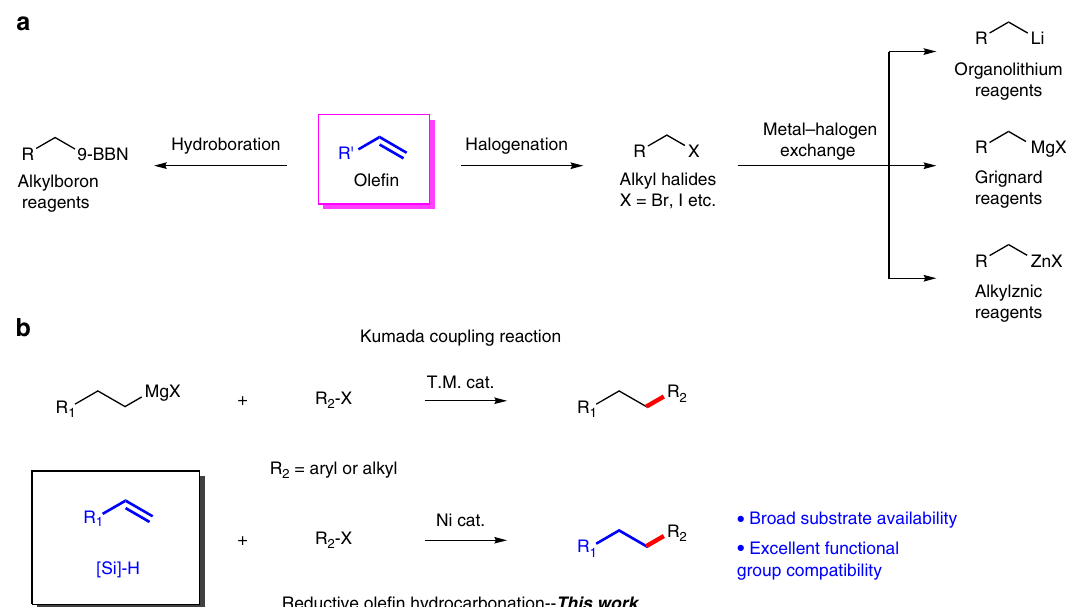
Figure 1 | Carbon–carbon bonds formation from olefins. ( a ) Alkyl organometallic reagents used in cross-coupling reactions. Alkylboron reagents 47–49 are usually made through alkene hydroboration. Grignard 50,51 , organolithium 52,53 and alkylznic reagents 42,54 are generally obtained through insertion of metals into alkyl halides. However, an often ignored problem is that most terminal alkyl halides are converted from olefins 55 . ( b ) Comparison of reductive olefin hydrocarbonation reaction with transition metal-catalyzed Kumada-coupling reaction. From a viewpoint of synthetic chemistry, the combination of olefins with silanes could be recognized as equivalent to alkyl organometallic reagents. 9-BBN ¼